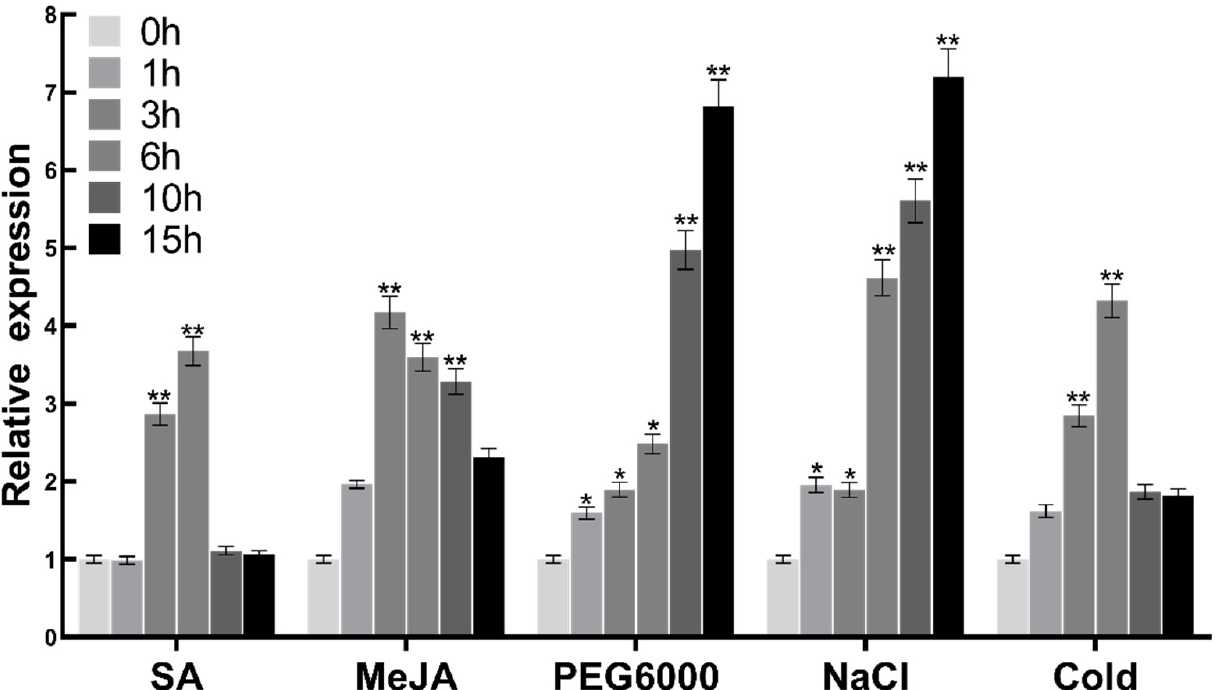
Figure 3. Expression of FtMYB3 in Tartary buckwheat under different treatments (1 mmol/L SA, 2 mmol/L MeJA, 30% PEG6000, 150 mmol/L NaCl). The samples were collected after respective treatments for 0, 1, 3, 6, 10, and 15 h. The relative expression of FtMYB3 was analyzed by qPCR, and the expression level of FtMYB3 at 0 h was defined as 1. The expression level was calculated from three replicates. Error bars denote ± SDs. ** means extremely significant difference at p < 0.01 level; * means significant difference at p < 0.05 level.